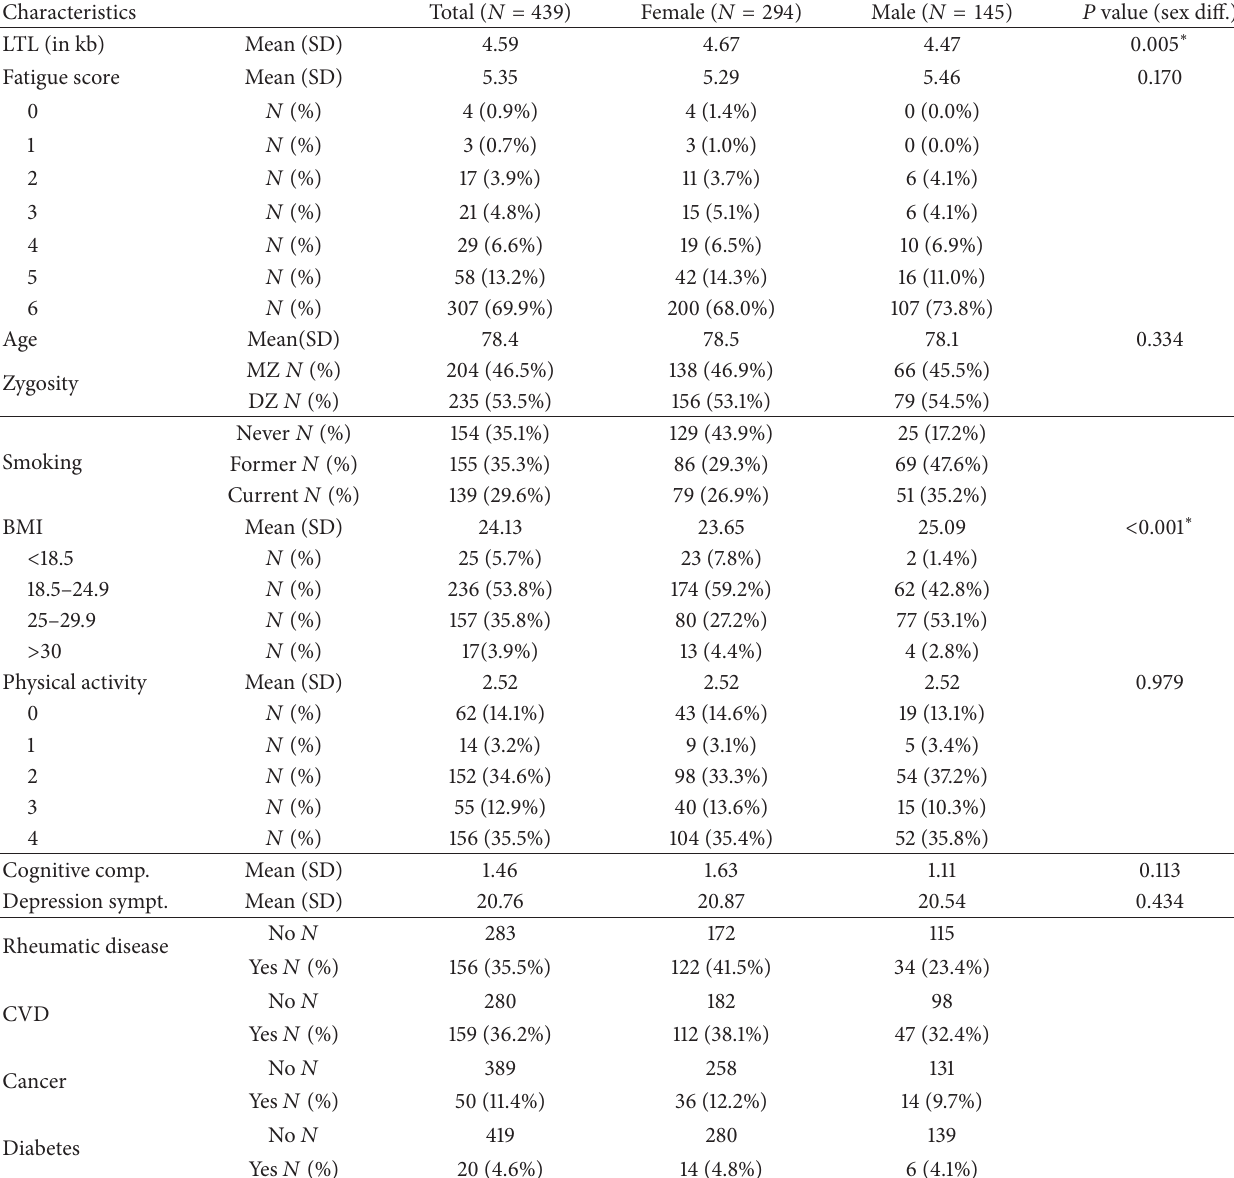
Table 1: Descriptive statistics of the study population, including data on mean LTL, fatigue and lifestyle, mental health and somatic disease